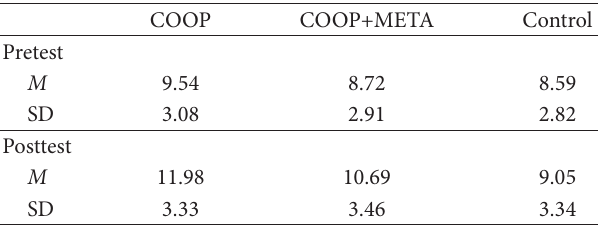
T 4: Mean scores and standards deviations on “developing and evaluating solutions” (scale 2) by time and